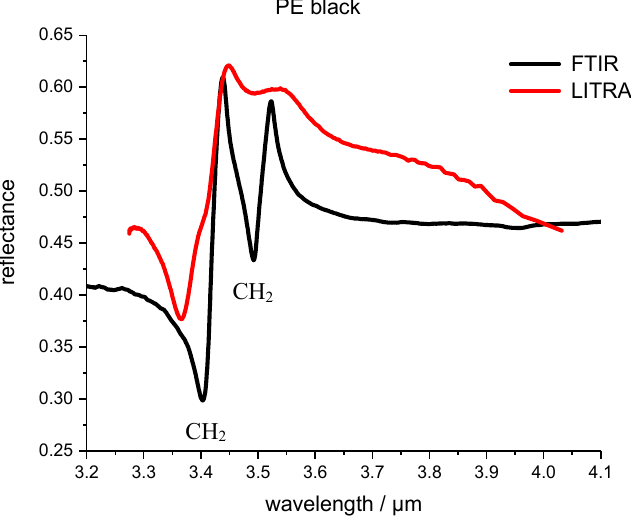
Figure 4. FTIR and LITRAN reflectance spectrum of polyethylene (PE) black polymer. LITRAN is the spectrum measured with the up conversion system.